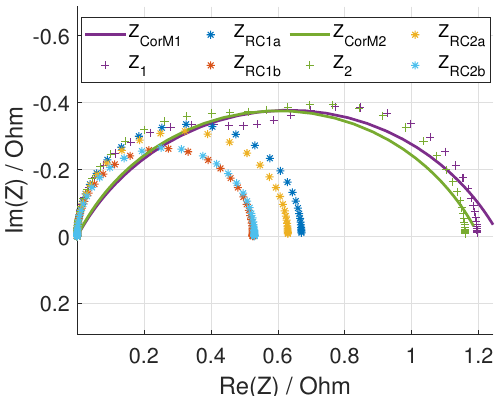
Figure 7. Reproduction of the reduced spectra from cell I: Z RC 1 a , Z RC 1 b represent the impedances of the RC elements of two electrodes of the first measurement, Z 1 their sum and Z CorM 1 the cor- responding (reduced) measured impedances. The impedances of the second measurement are denoted accordingly.